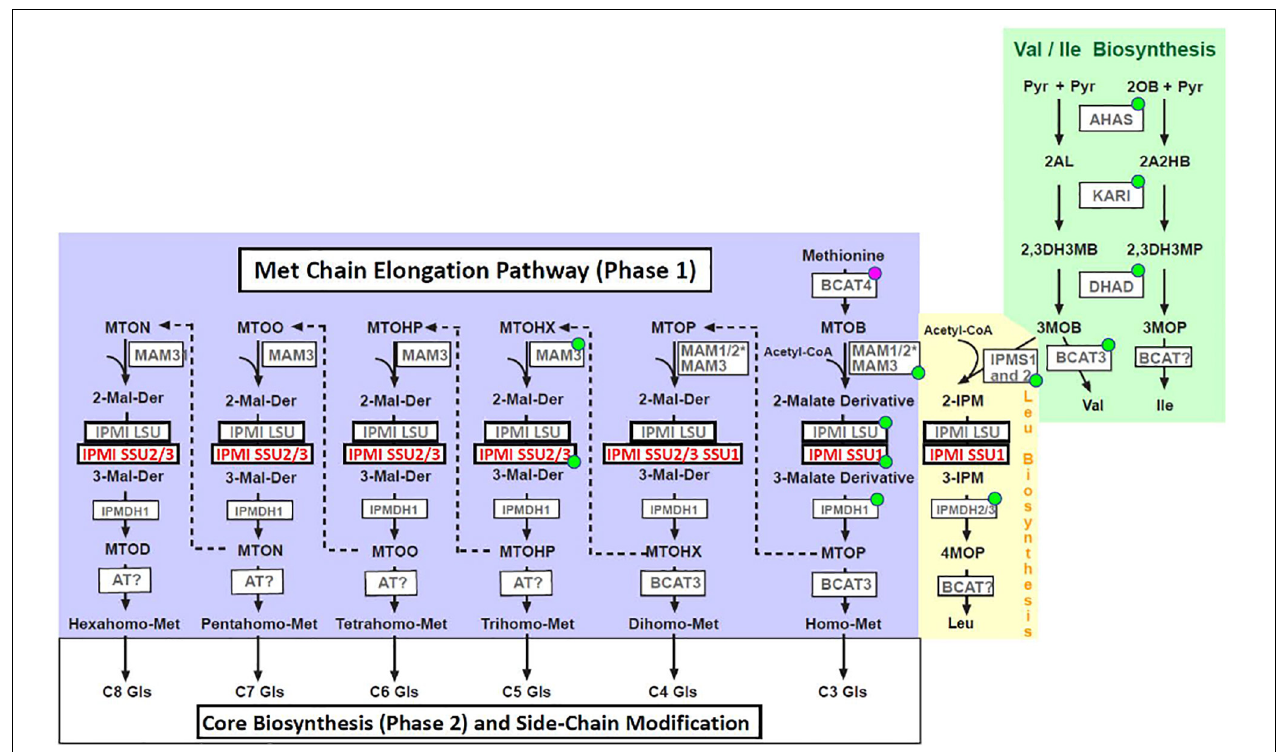
FIGURE 1 | Metabolites and enzymes of branched-chain amino acid biosynthesis (Val and Ile: green box, Leu: yellow box) and methionine chain elongation pathway (blue box). Abbreviations of metabolites: Pyr, pyruvate; 2OB, 2-oxobutanoate; 2AL, 2-acetolactate; 2A2HB, 2-aceto-2-hydroxybutyrate; 2,3DH3MB, 2,3-dihydroxy-3-methylbutanoate; 2,3DH3MP, 2,3-dihydroxy-3-methylpentanoate; 3MOB, 3-methyl-2-oxobutanoate; 3MOP, 3-methyl-2-oxopentanoate; 4MOP, 4-methyl-2-oxopentanoate; 2-IPM, 2-isopropylmalate; 3-IPM, 3-isopropylmalate; MTOB, methylthiooxobutanoate; MTOP, methylthiooxopentanoate; MTOHX, methylthiooxohexanoate; MTOHP, methylthiooxoheptanoate; MTOO, methylthiooxooctanoate; MTON, methylthiooxononanoate; MTOD, methylthiooxodecanoate, 2-Malate-Derivative, 3-Malate-Derivative; Gls, glucosinolate. Abbreviations of enzymes: AHAS, acetohydroxyacid synthase; KARI, ketolacid reductoisomerase; DHAD, dihydroxyacid dehydratase; BCAT, branched-chain aminotransferase; IPMS, isopropylmalate synthase; MAM, methylthioalkylmalate synthase; IPMI LSU, isopropylmalate isomerase large subunit; IPMI SSU, isopropylmalate isomerase small subunit; IPMDH, isopropylmalate dehydrogenase; AT, aminotransferase. Enzymes marked with a green dot localize to plastids according to SUBA4 (http://suba.live/, Hooper et al., 2017). BCAT4 is located in the cytosol. *The presence or absence of MAM1 or MAM2 is ecotype-dependent. Both enzymes are involved in early phases of Met chain elongation leading to predominantly C4 (MAM1, for instance in Col) or C3 (MAM2, for instance in Ws) glucosinolates (Kroymann et al., 2003).